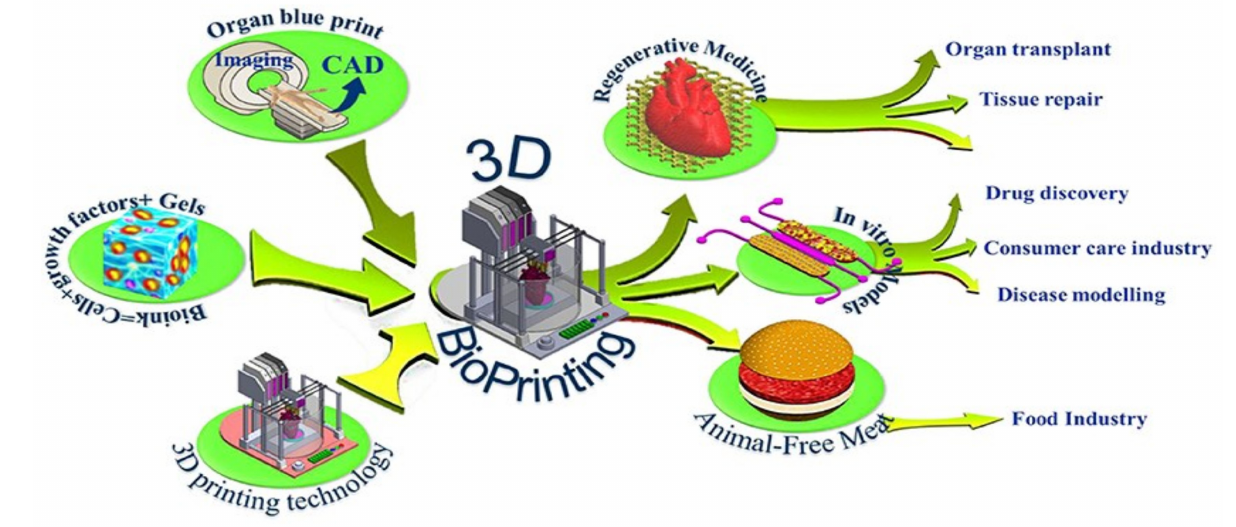
Figure 1. Numerous applications of 3D bio-printing. Reprinted with permission from [20]. Copyright 2021, MDPI. Distributed under Creative Commons Attribution—based license (CCBY